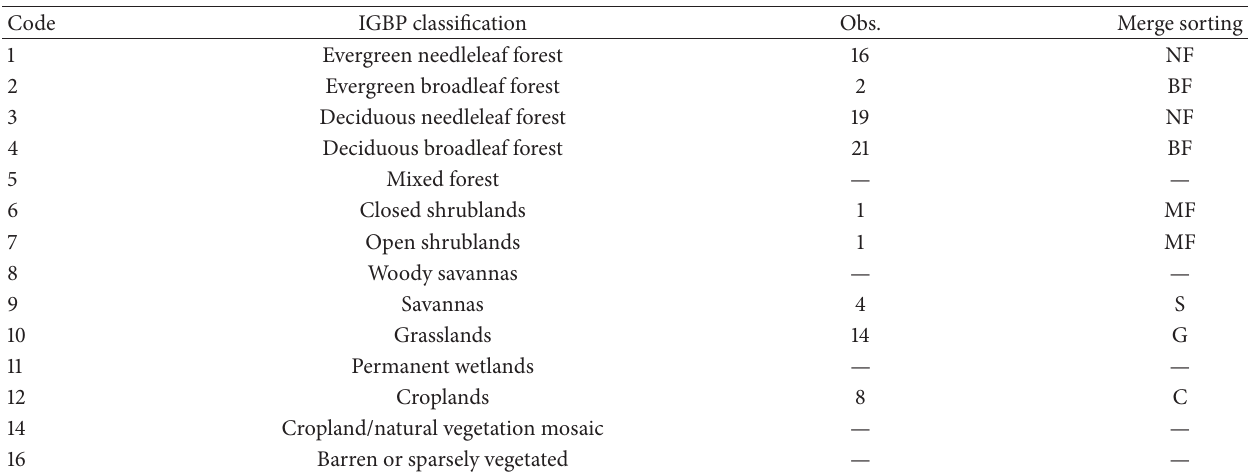
Table 2: Sites statistical distribution in IGBP land cover classification system.